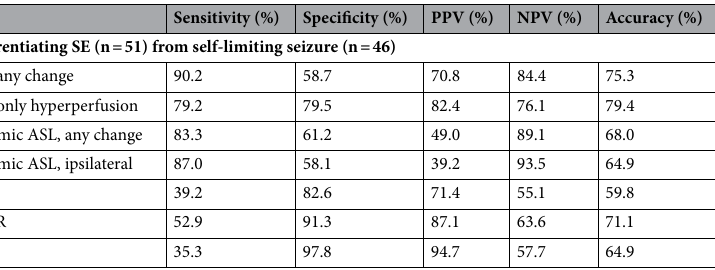
Table 2. Sensitivity, specificity, PPV, NPV, and accuracy of each method with SE versus self-limiting seizure. PPV positive predictive value, NPV negative predictive value, SE status epilepticus, ASL arterial spin labeling,